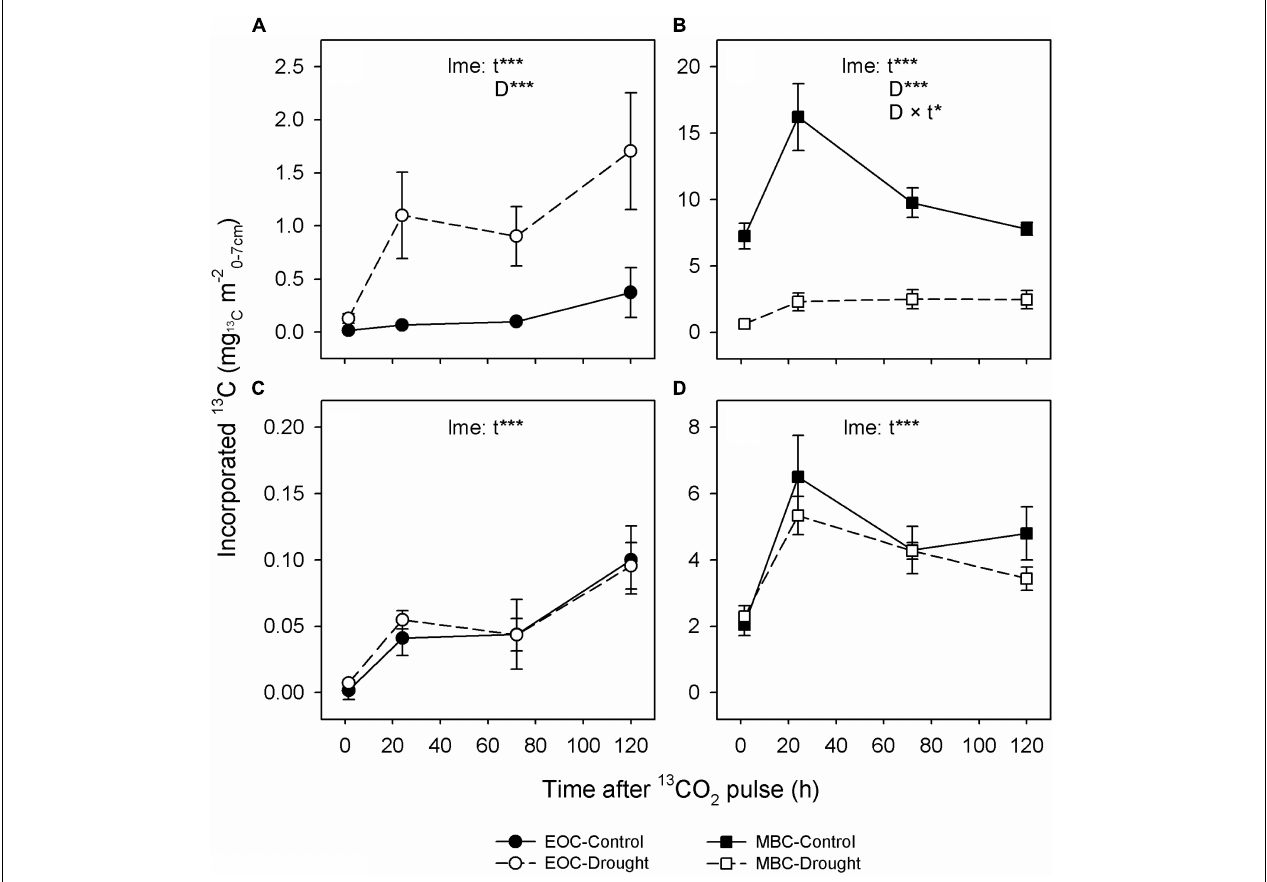
FIGURE 2 | Dynamics of 13 C tracer incorporation into extractable organic carbon (EOC; circles; A,C ) and microbial biomass carbon (MBC; squares; B,D ) from soil of control (closed symbols and solid lines) and drought-treated (open symbols and dashed lines) mesocosms at the peak drought (A,B) and recovery (C,D) labeling campaigns. Error bars show the SE of n = 6 mesocosms. Levels of significance for time after labeling ( t ; df = 3), drought treatment (D; df = 1) and the interaction of both (D × t; df = 3) were obtained from linear mixed-effects (lme) models using the R package ‘lme4’; ∗∗∗ P χ 2 < 0.001, ∗∗ P χ 2 < 0.01, ∗ P χ 2 < 0.05. Note that the labeling time was 30 min at the recovery labeling compared to 75 min at the peak drought labeling and that the absolute values cannot be compared between the labeling